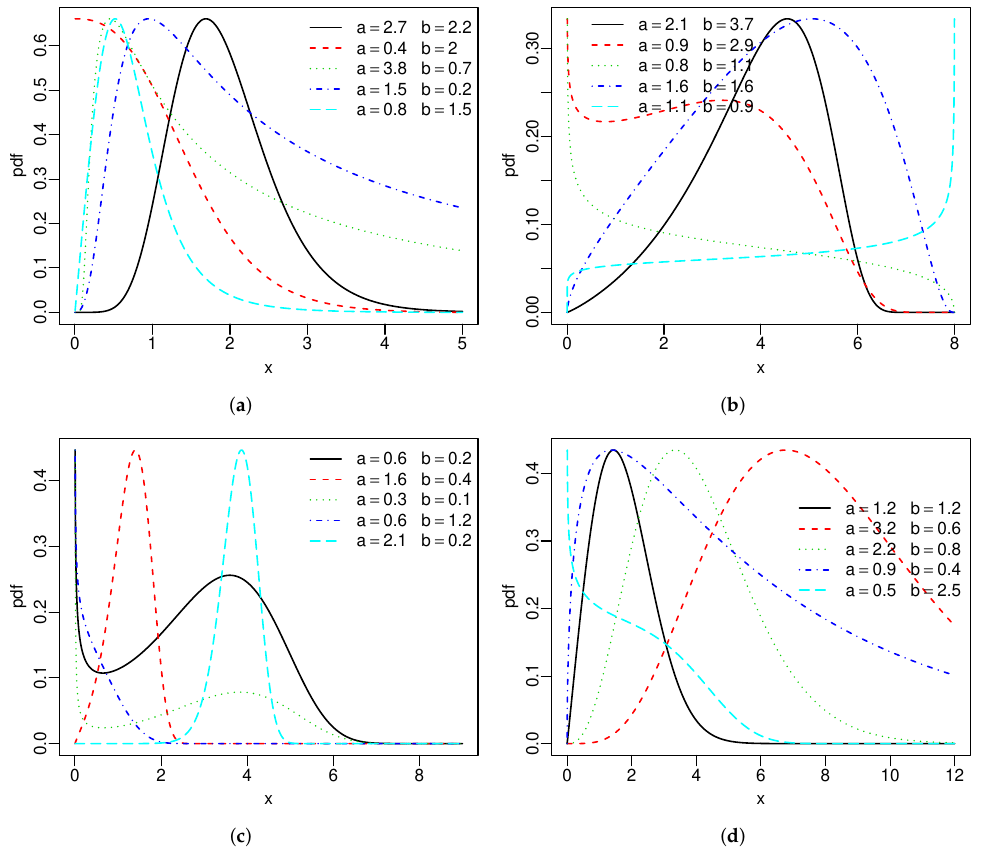
Figure 1. Special densities: ( a ) SBXII ( a , b ,1.2,0.7,2.5 ) , ( b ) SU ( a , b ,0,8 ) , ( c ) SC ( a , b ,1.7,1.3 ) and ( d ) SW ( a , b ,0.5,1.7 ) .